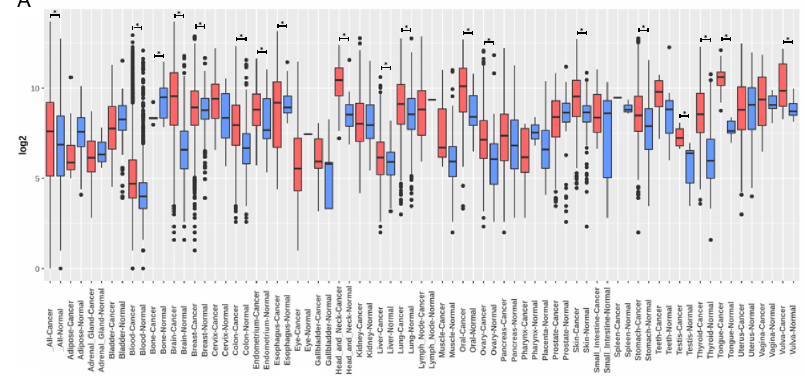
Figure 6. TNC expression is increased in lung cancer, but does not correlate with lung cancer sur- vival. ( A – C ) TNC expression generated from http://gent2.appex.kr/gent2/ (accessed on 1 Novmber 2022) [24]. (A) TNC expression in different tissues. ( B ) TNC expression in normal lung (n = 508) and lung cancer (n = 2362). ( C ) TNC expression in different subtypes of lung cancer (I, IA, IB, II, IIA, IIB, IIIA, IIIB, IV). ( D ) Overall survival curve of the high and low expression of TNC in patients with lung cancer (generated from http://gepia2.cancer-pku.cn/#survival, accessed on 1 Novmber 2022) [25]. ( E – F ) Overall survival curve generated using Kaplan–Meier plotter (http://kmplot.com/analy- sis/, accessed on 1 Novmber 2022) and UALCAN (http://ualcan.path.uab.edu/, accessed on 1 Novmber 2022) ( E ) Overall survival curve of the high and low expression of TNC in patients